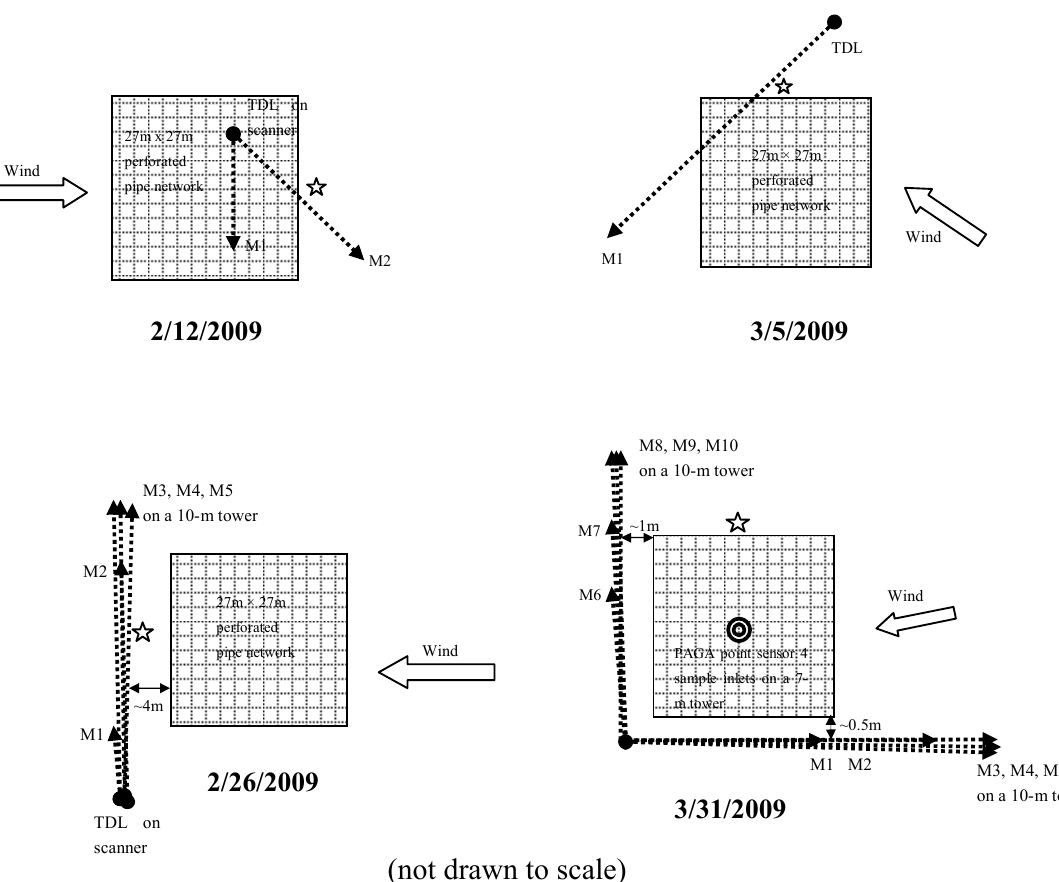
Figure 1. Layouts for single emission source experiment ( : 3D sonic anemometer; M: location of